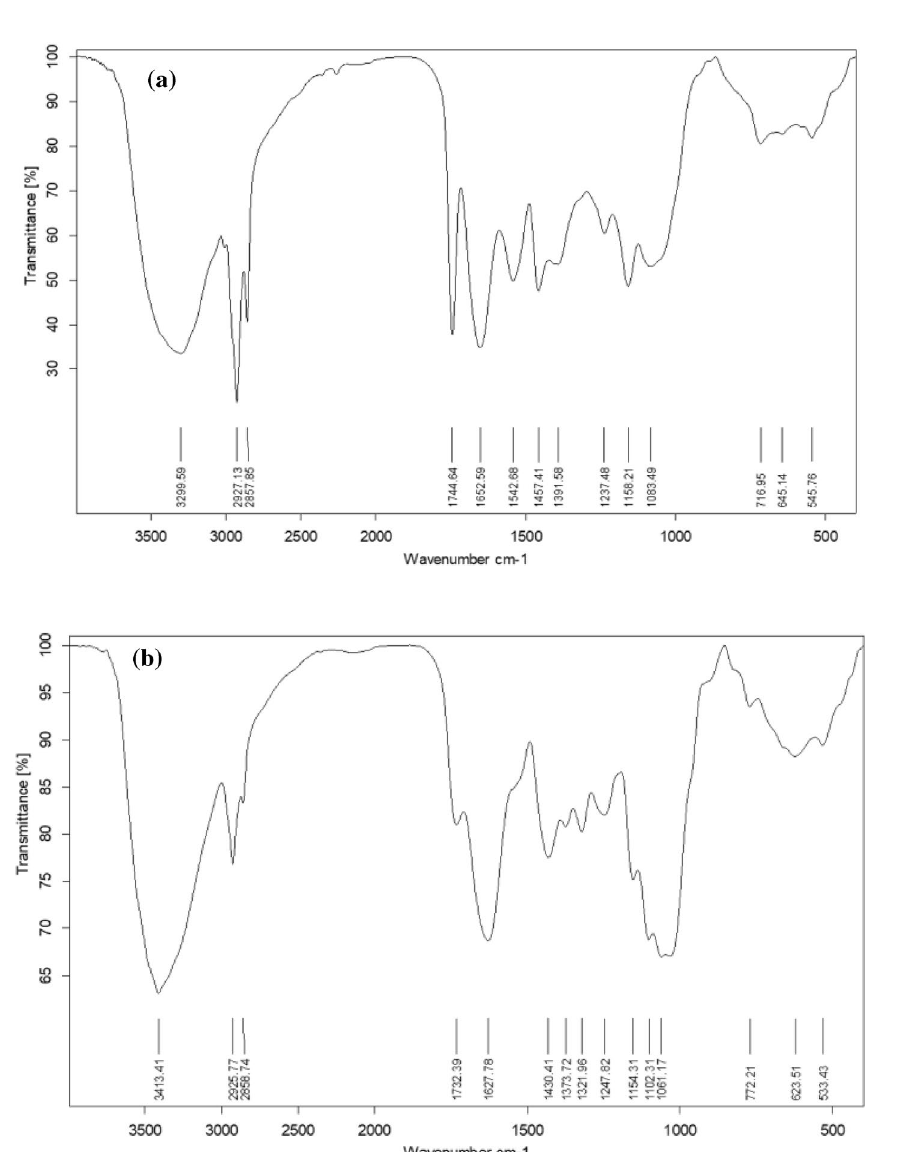
Figure 1. FTIR spectra of ( a ) Fen and ( b ) CgL